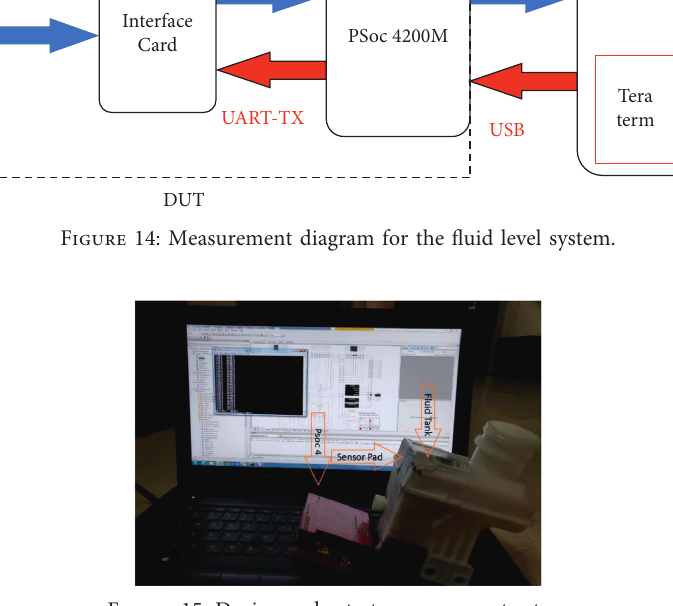
Figure 15: Device under-test-measurement setup.